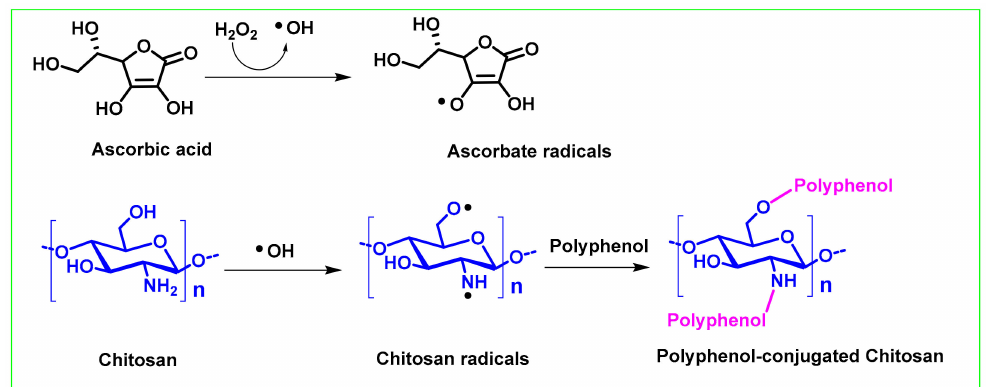
Figure 2. Proposed mechanism of synthesis of polyphenol chitosan conjugate by free radical induction